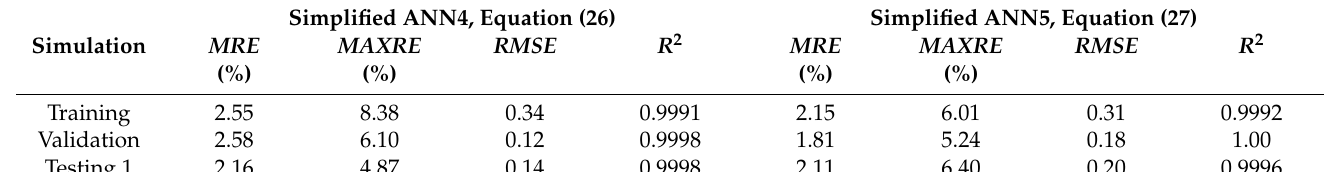
Table 9. Statistical measures for ANN4 Equation (26) and ANN5 Equation (27).